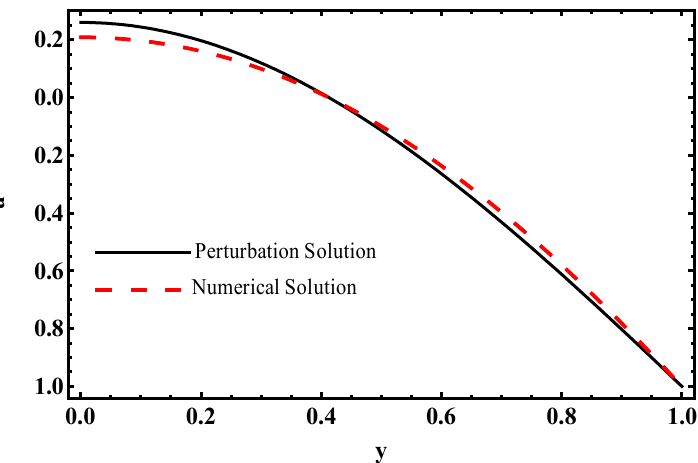
Figure 2. Comparative analysis between Perturbation solution and Numerical solution for axial velocity, whileotherparametersare Г = 0.01, x = π , ε = 0.2, Θ = 1, m e = 2, U hs = − 1, B r = 1, S c = 1, S r = 1 .